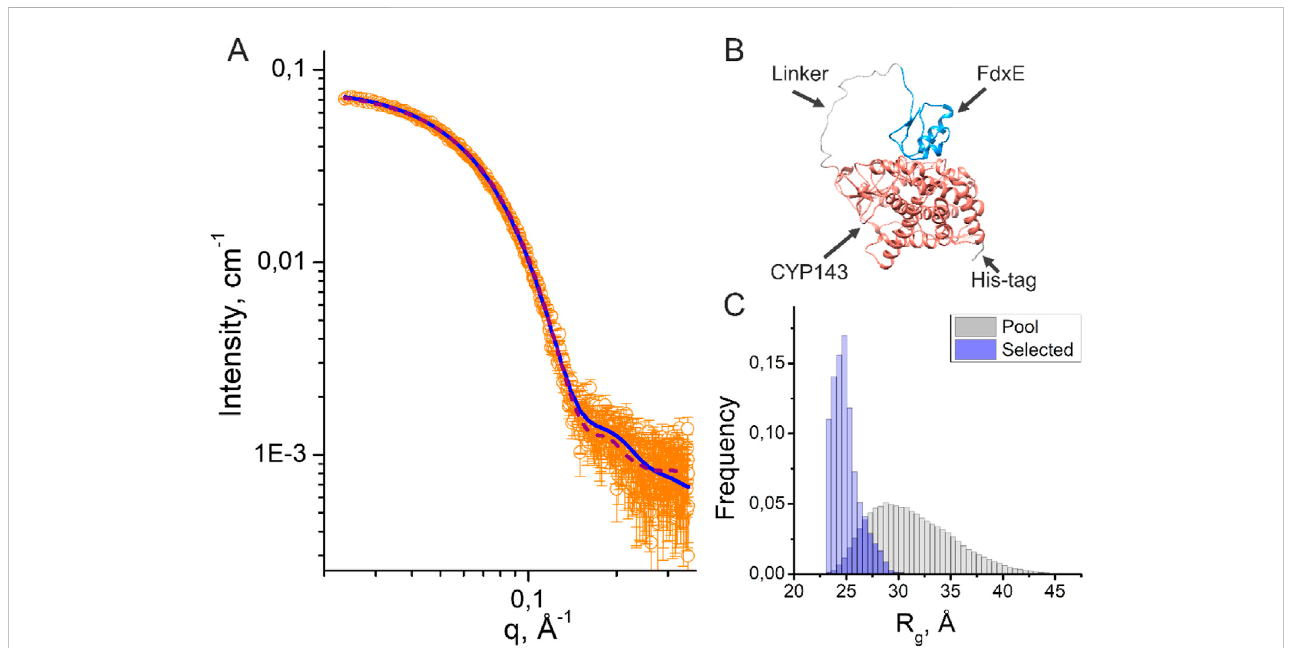
Results of SAXS data analysis of the fusion FdxE − CYP143 complex. (A) SAXS I(q) pro fi le (orange circles) and their approximations corresponding to the PDB models obtained by using CORAL (purple dashed line) and EOM (blue solid line); (B) CORAL model of the fusion FdxE-CYP143 complex; (C) Rg distributions for the initial pool (gray histogram) and for a set of selected conformations (blue histogram) in the EOM (Supplementary Figure